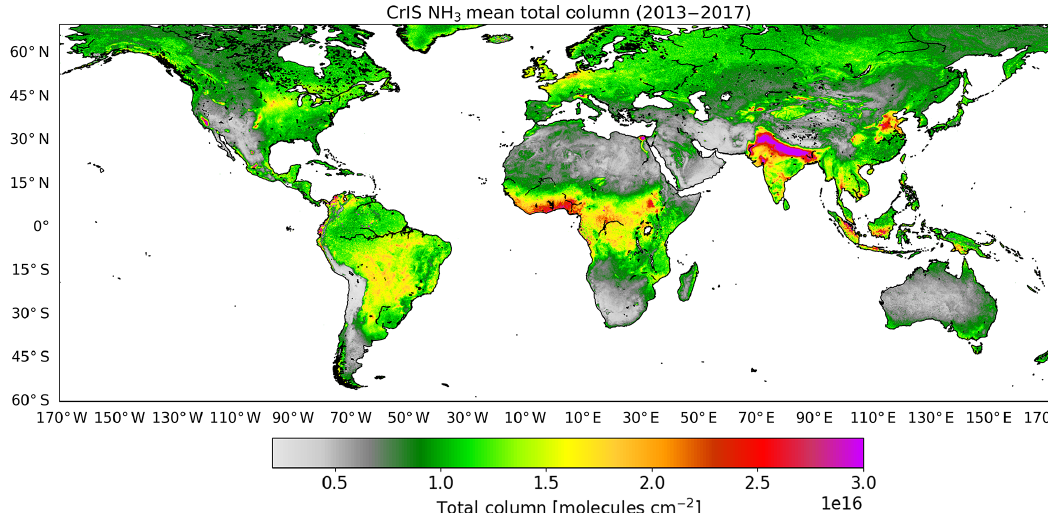
Figure C1. Similar to Fig. 5 but for total column amounts.